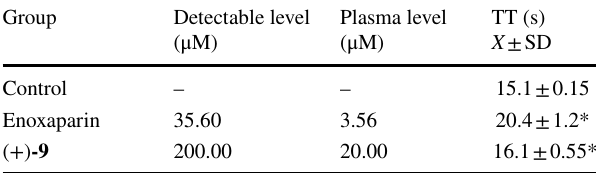
* P < 0.05, ** P < 0.01, *** P < 0.001 versus Table 7 Inhibitory effects of the isolates on TT (n = 3)